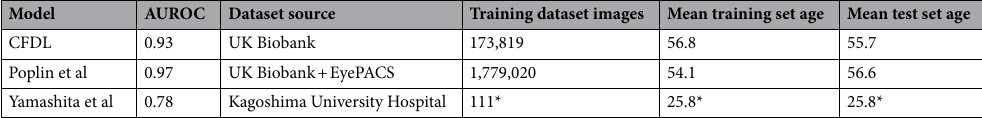
Table 1. Comparison of reported fundus photo sex prediction algorithms. *Cross-validation.